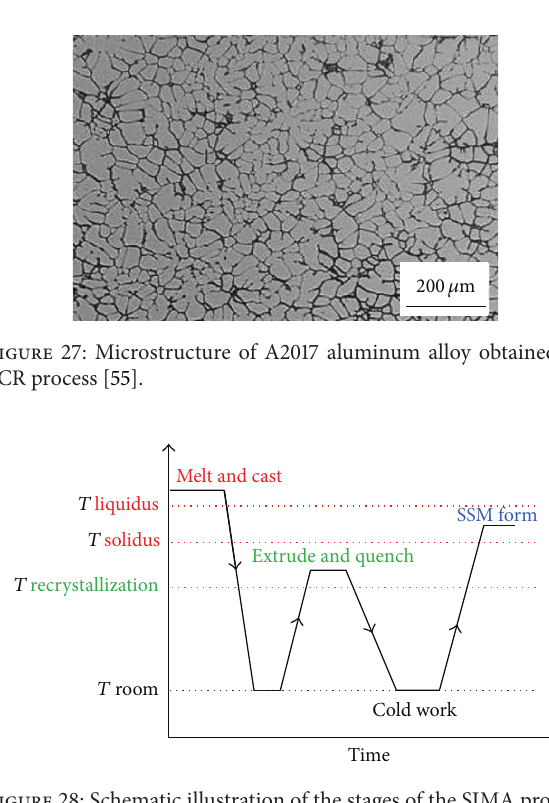
Figure 28: Schematic illustration of the stages of the SIMA process [56].